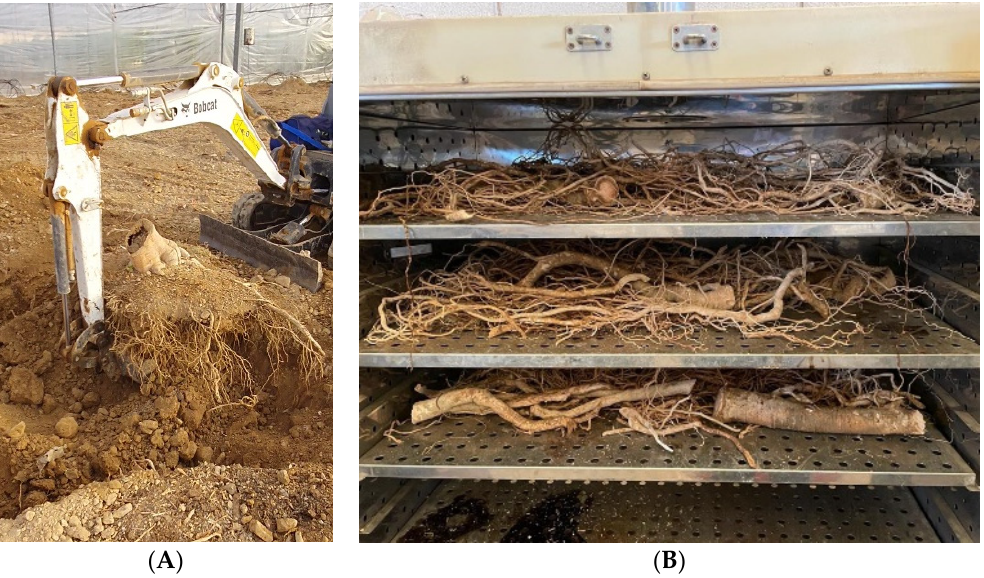
Figure 7. ( A ) Root extraction and ( B ) drying at 65 °C of ‘Alicia’ papaya plants propagated by seed, grafting, and in vitro.